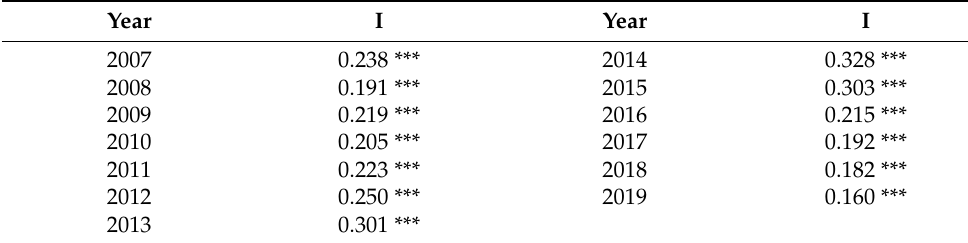
Table 4. Economic high-quality global Moran index.